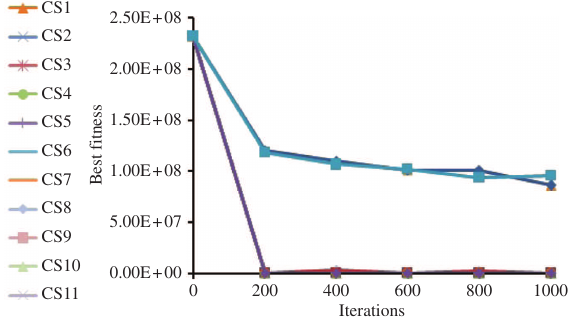
Figure 6: Convergence Trend of f 12